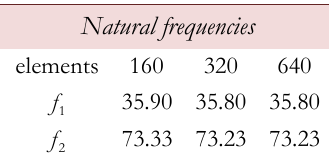
Table 2: Natural frequencies obtained with three different discretizations of the arch model.